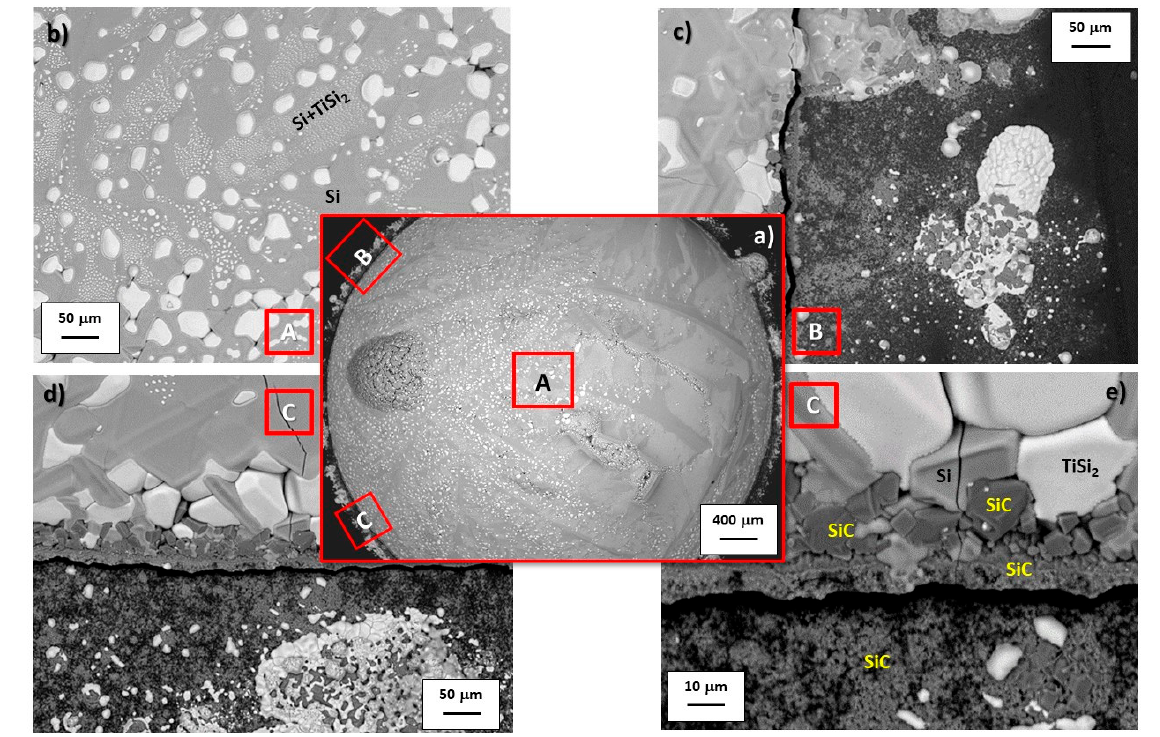
Figure 7. SEM-BSE and proposed phase identification by EDS analyses performed at different magnifications at the top ( a , b ) and at the triple line ( c – e ) of the solidified Si-24at%Ti/GC sample after the wetting test performed by the dispensed drop method at T =1450 °C under an Ar atmosphere. A: top drop; B and C Different areas at the triple line